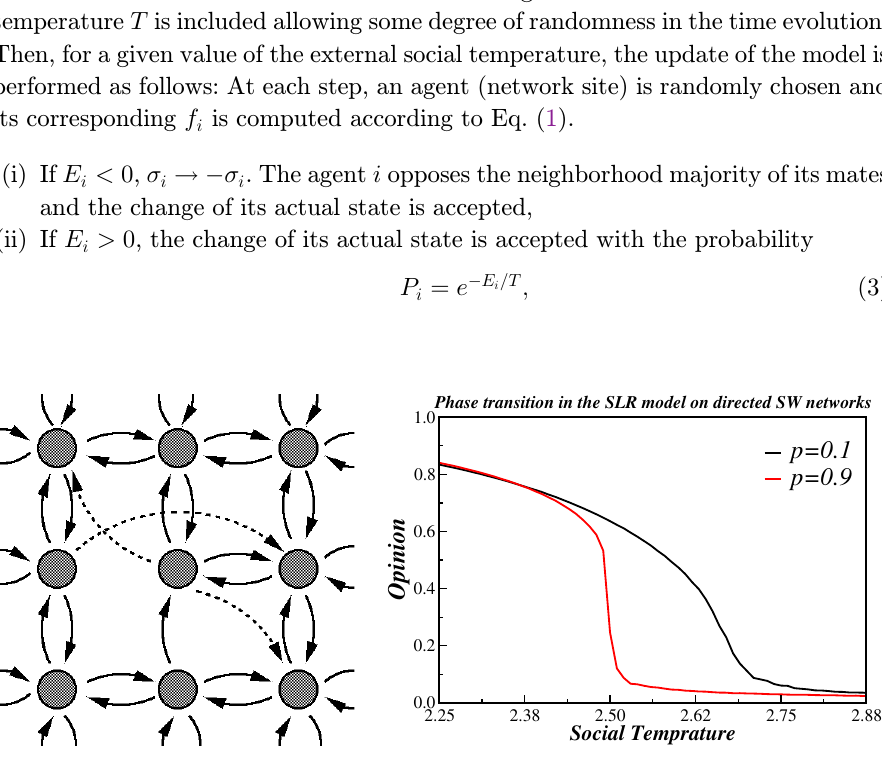
Fig. 1. On the left, we show a DSW network in two dimensions where the dotted lines represent rewired links. 11 On the right, we show two types of phase transition. For rewiring probabilities p ¼ 0 : 1 (black line), the SLR model presents a continuous phase transition and a discontinuous phase transition for p ¼ 0 : 9 (red